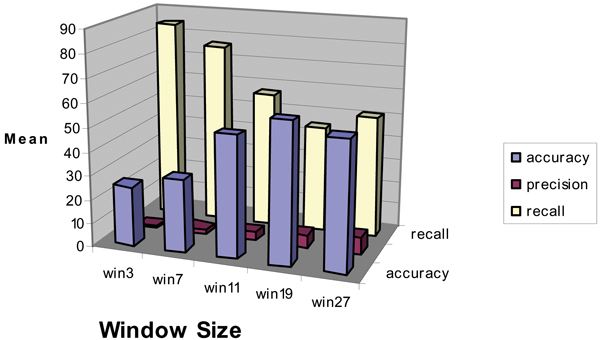
Six-fold cross-validation results for DomainDiscovery (in average); determined by using SVM classifiers for the Benchmark_2 dataset.